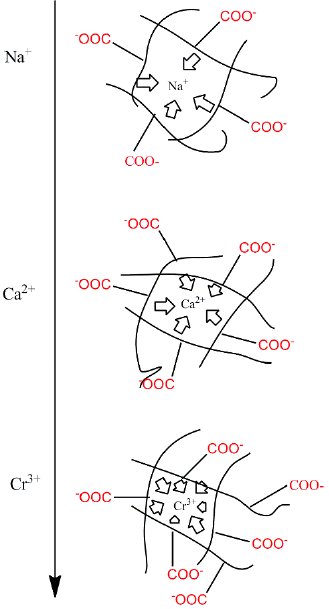
Figure 6. A schematic diagram of ionic charge shielding effect.